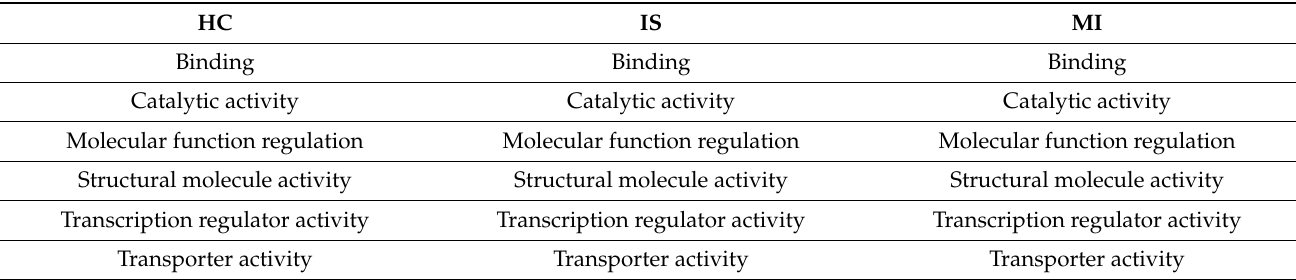
Table 3. The enriched gene ontology molecular function in healthy controls and patients with ischaemic stroke and myocardial